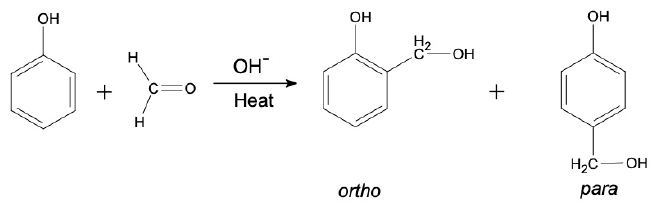
Figure 2. Addition reaction of formaldehyde to phenol [12].